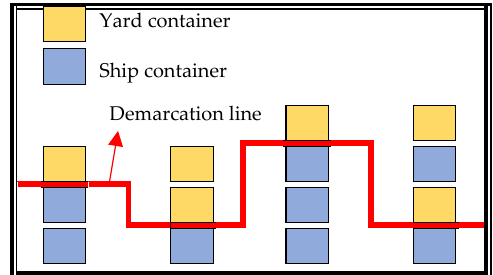
Figure 11. Examples of the “demarcation line”.